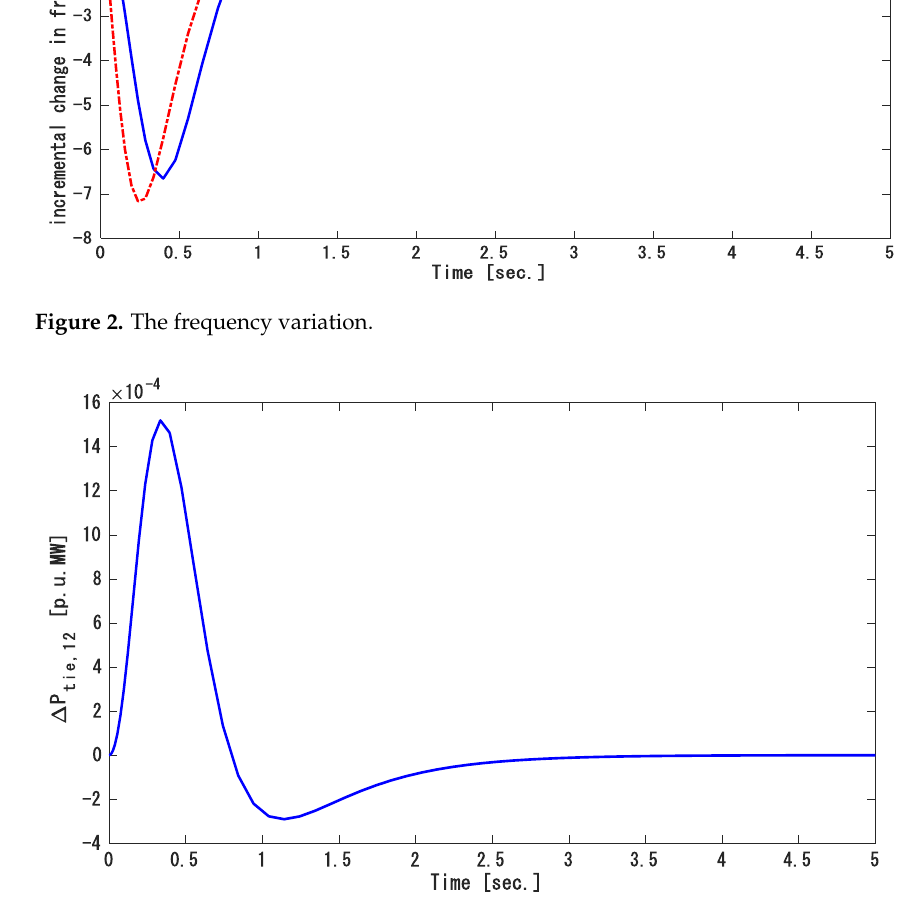
Figure 3. The tie-line power deviations.